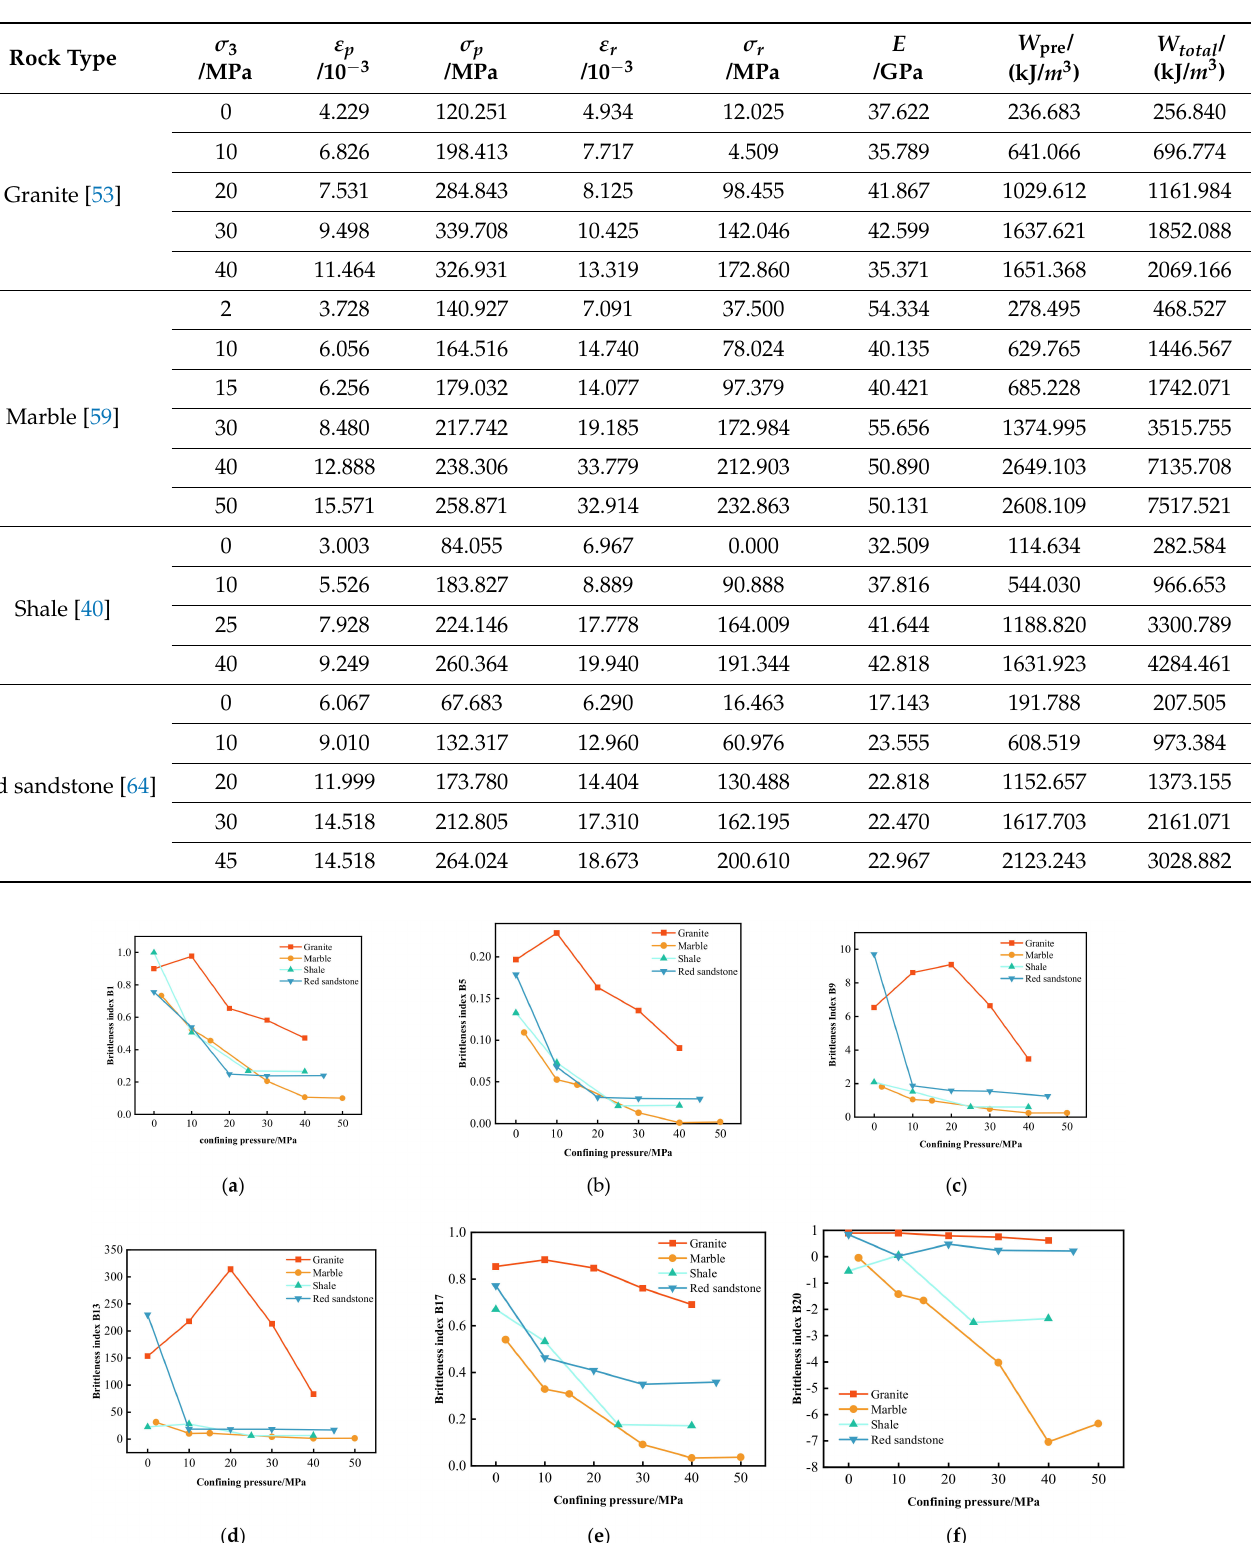
Table 3. Mechanical parameters of various rocks under different confining pressures.